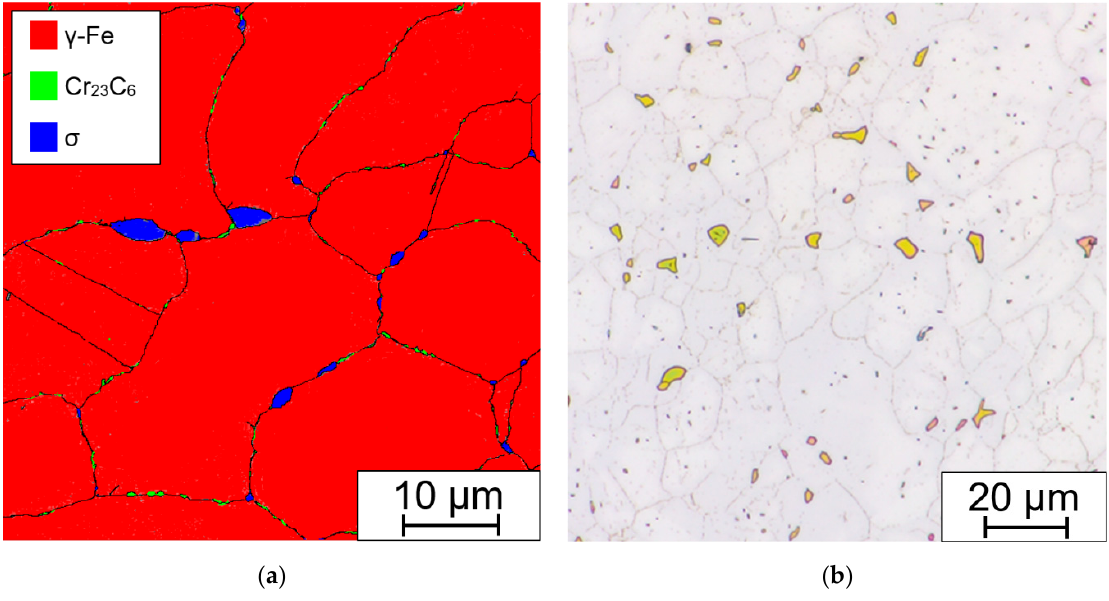
Figure 20. Sample aged at 675 °C/ 20,000 h: ( a ) phase map from EBSD; ( b ) optical micrograph, etched in 20% NaOH electrolyte (1.5 V DC, 1 s).